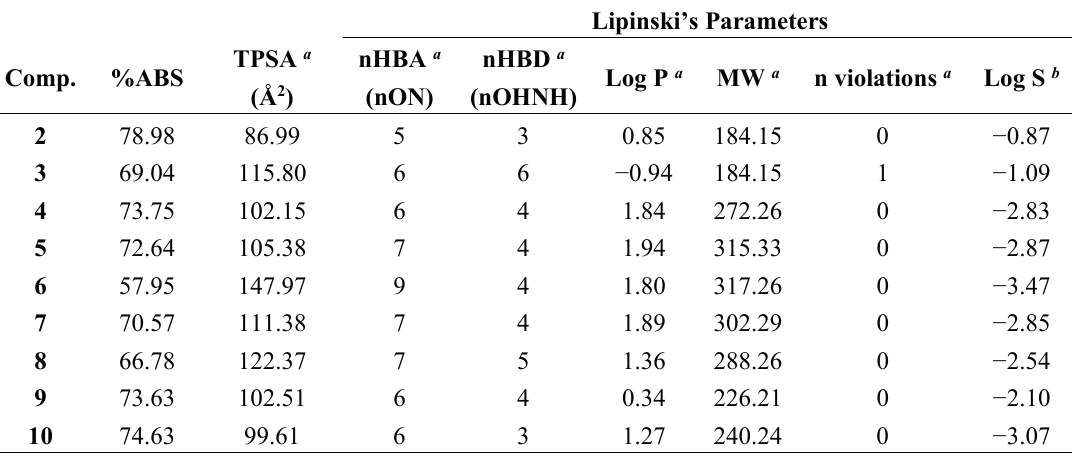
Table 3. Lipinski’s rule and %ABS, TPSA, Log S for compounds 2 – 10 . Lipinski’s